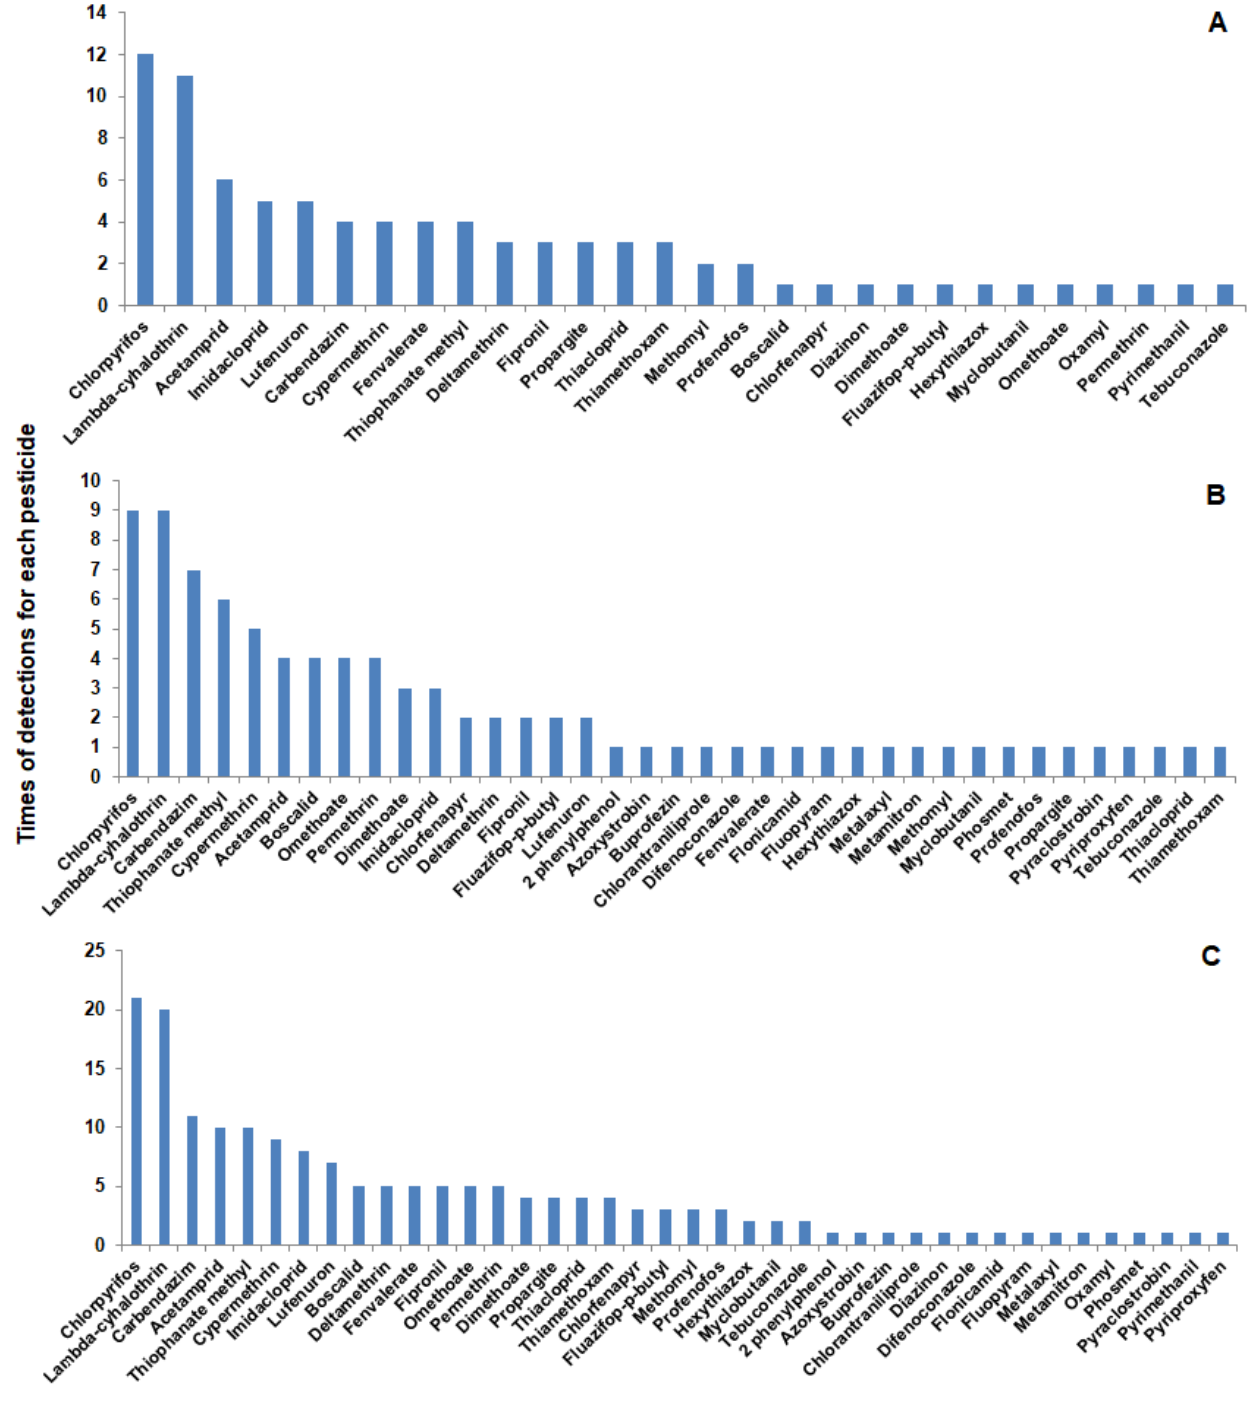
Figure 2. Pesticides detected in vegetables and fruits and times of detection for each pesticide in vegetables ( A ), fruits ( B ), and the total in both vegetables and fruits ( C ).